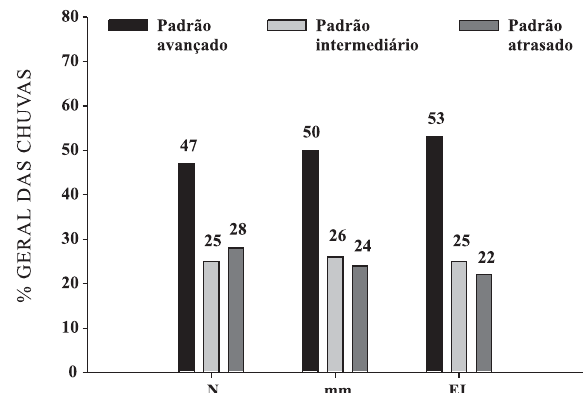
Figura 5. Distribuição da precipitação média mensal por padrões hidrológicos das chuvas erosivas de São Borja, RS, no período de 1956 a 2003.